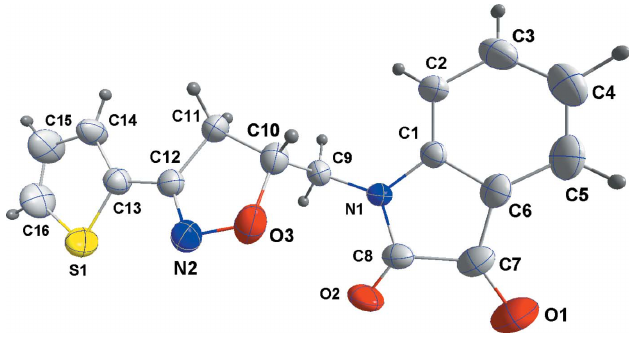
Figure 1 The molecular structure of the title compound, with the atom labelling and 40% probability displacement